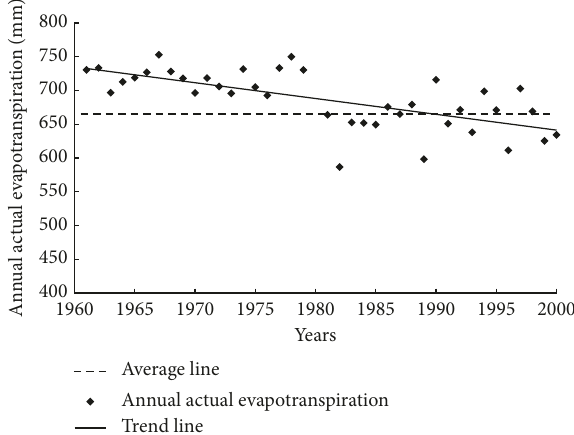
Figure 5: Variation of annual actual evapotranspiration in the upper reach of the Huaihe River Basin during